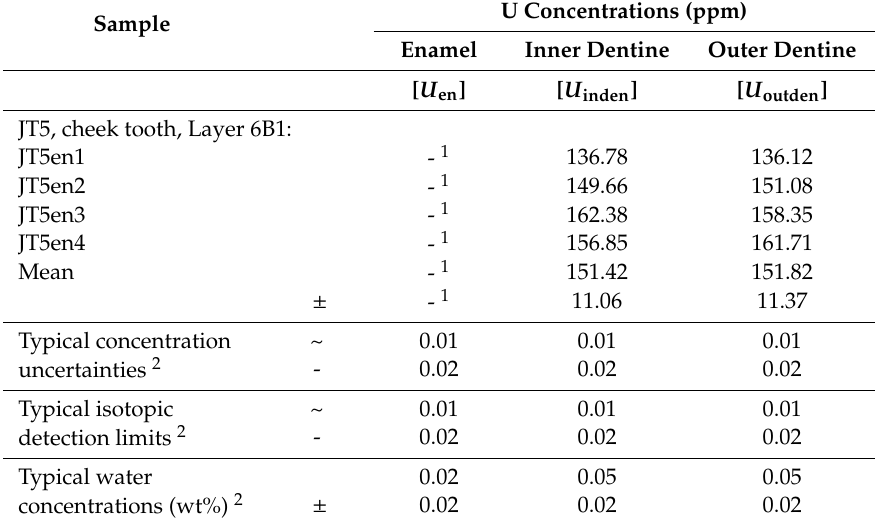
Table 3. Dental Radioactivity at Saradj-Chuko Grotto, Russia.